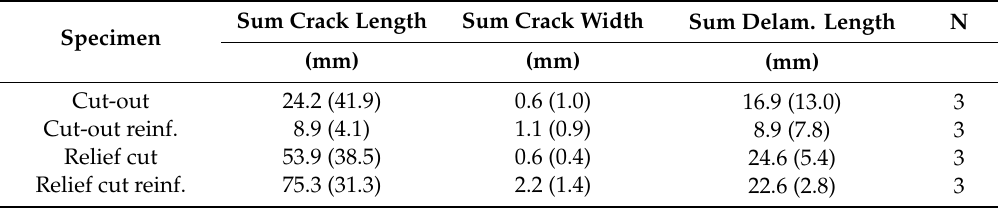
Table 3. Number and length of delamination after bending (SD in brackets).